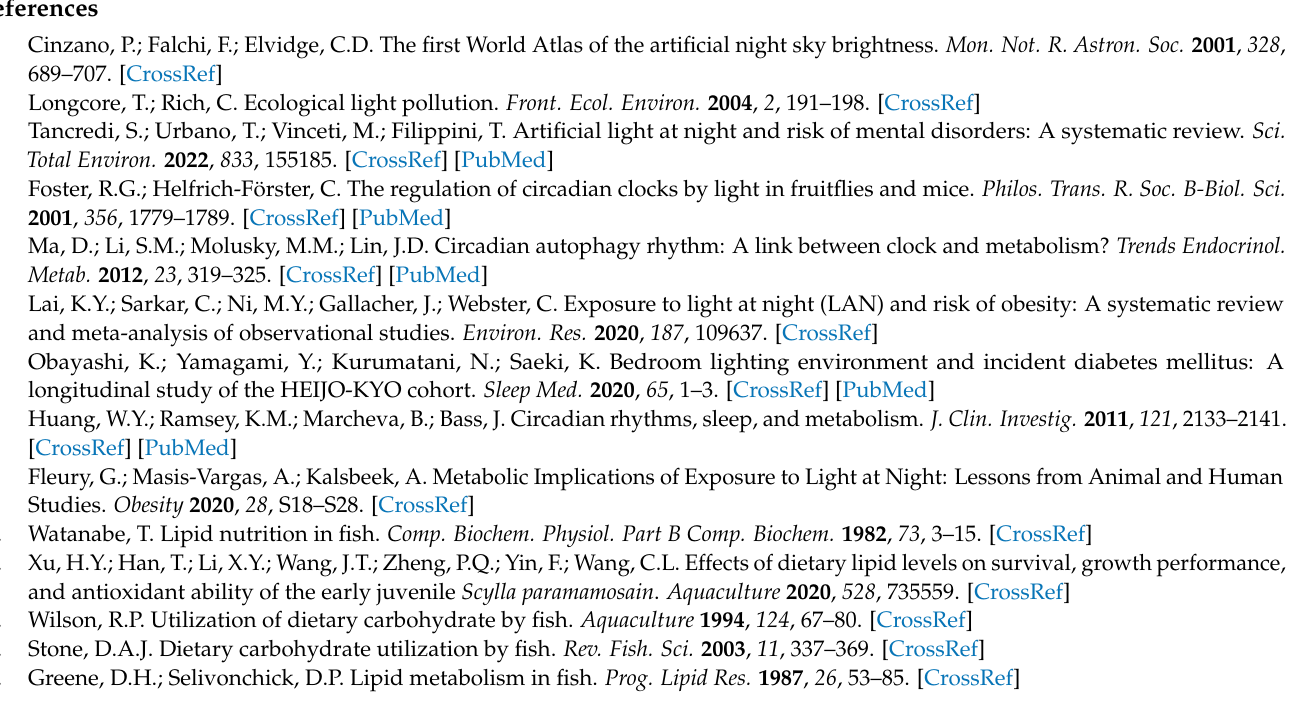
Table S1: The main nutrients of the commercial diet used in this experiment; Table S2: The specific primers used for real-time PCR in this study; Table S3: Proximate composition of juvenile Oncorhynchus mykiss under different experimental treatment; Table S4: Liver fatty acids composition of juvenile Oncorhynchus mykiss under different experimental treatment; Table S5: Serum fatty acids composition of juvenile Oncorhynchus mykiss under different experimental treatment; Table S6: Dorsal muscle fatty acids composition of juvenile Oncorhynchus mykiss under different experimental treatment; Table S7: Gene expression of juvenile Oncorhynchus mykiss under different experimental treatment. References [102–109] cited in the supplementary